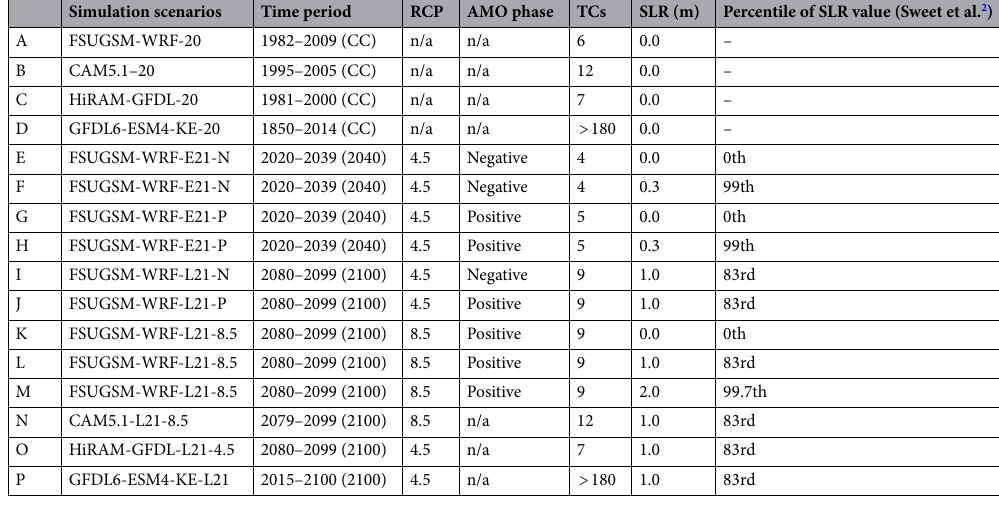
Table 1. Scenarios for coastal inundation